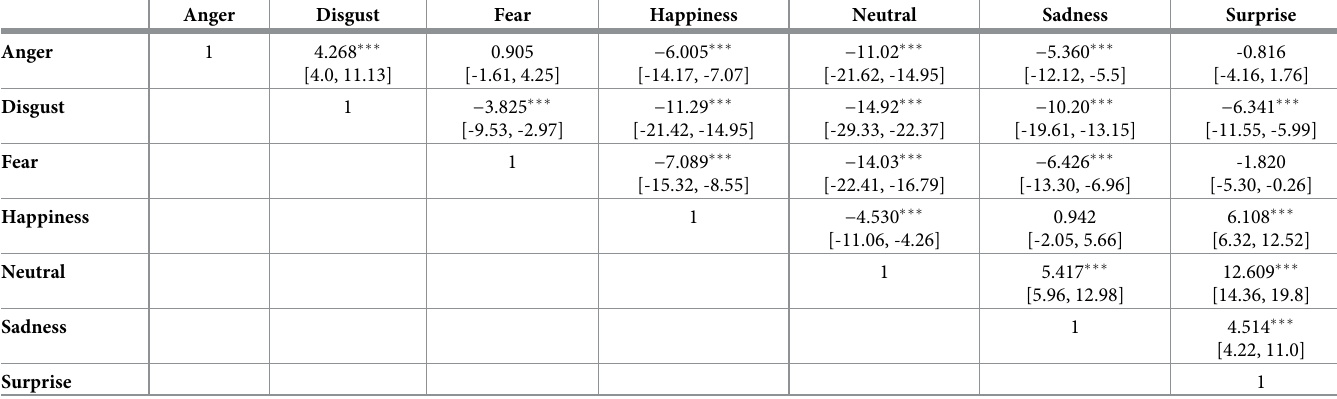
Table 18. Pairwise comparisons for Phase 1 emotions.